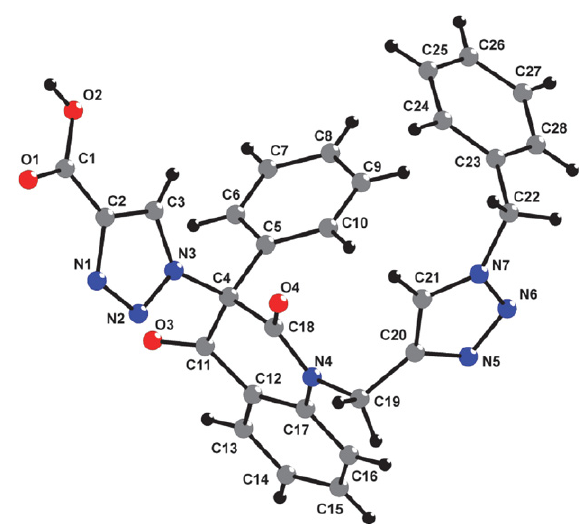
Figure 3. Crystallographic view and numbering scheme of the mol- ecule 12d · 2CDCl 3 . CDCl 3 molecules are omitted for clarity.